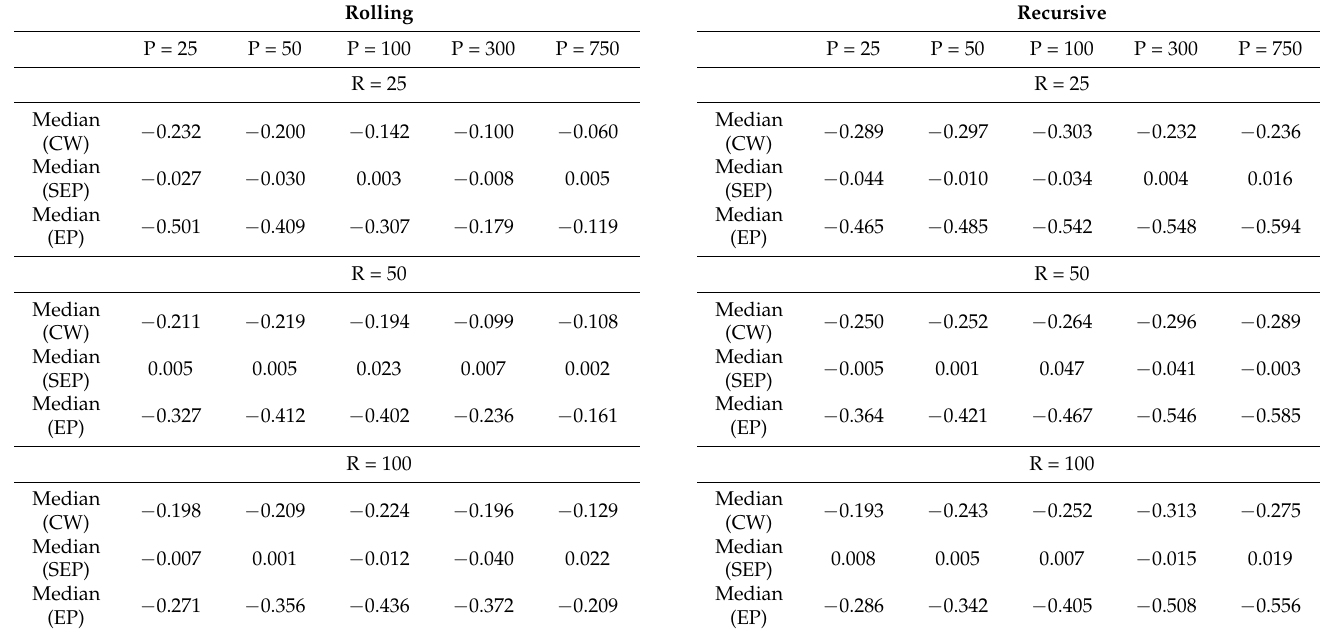
Table 9. Median of the Tests Statistics under the Null hypothesis: DGP2.